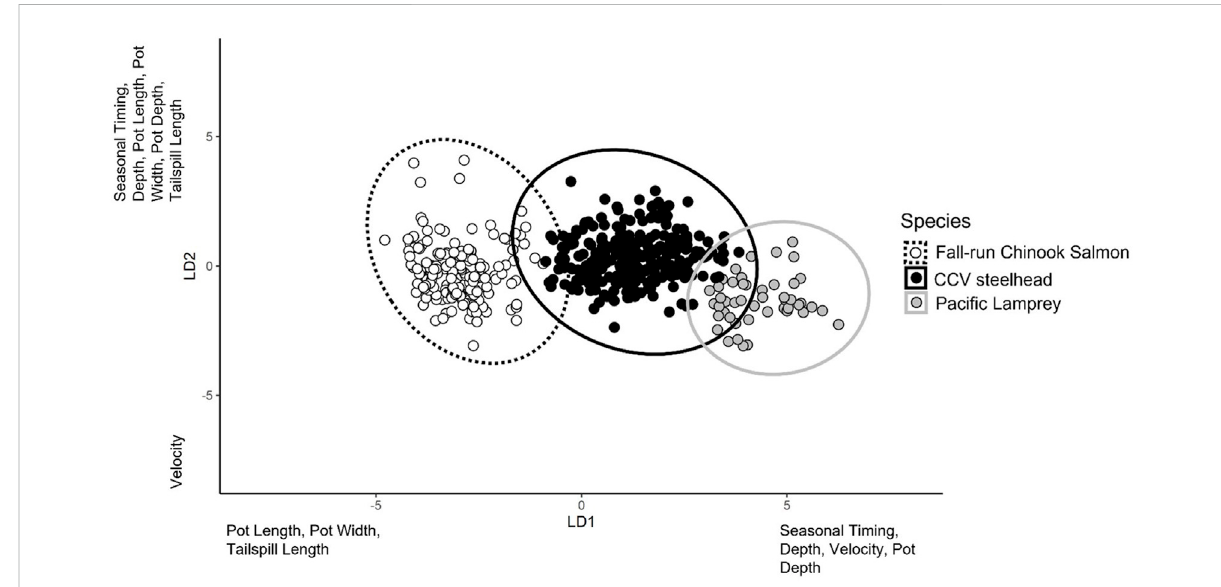
FIGURE 5 Scatter plot of linear discriminant analysis scores LD1 and LD2 describing variation across species of redds